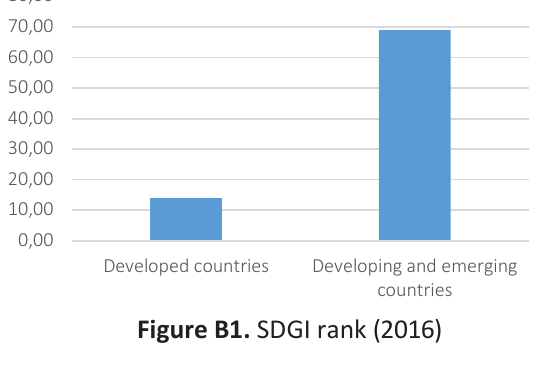
Figure B2. SDGI score (2016) Figure B1. SDGI rank (2016)